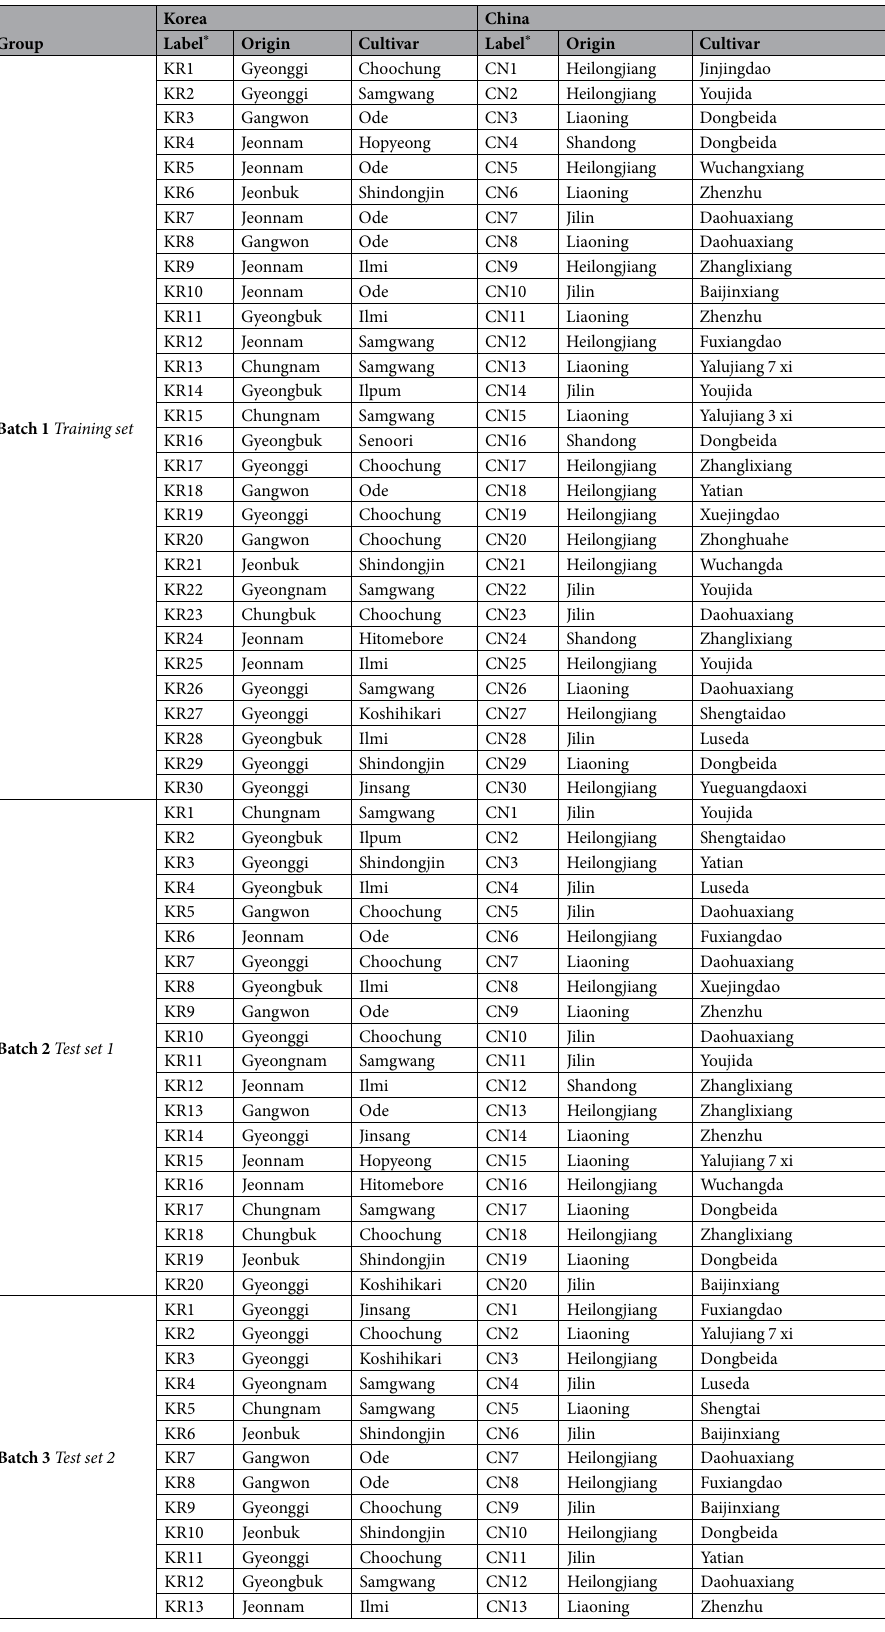
Table 1. The geographical origins and the cultivars of white rice from Korea and China. Some cultivars were purchased at the same province. However, they were cultivated in different areas and processed by different